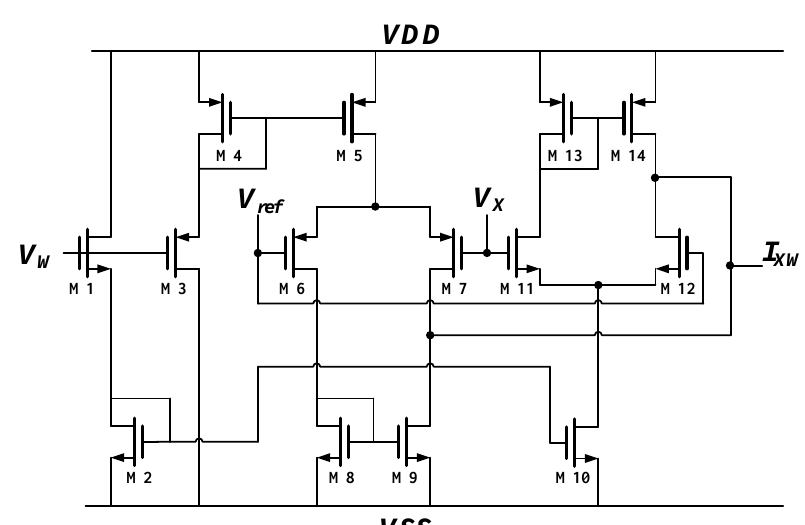
Figure 3. Schematic of Chible’s